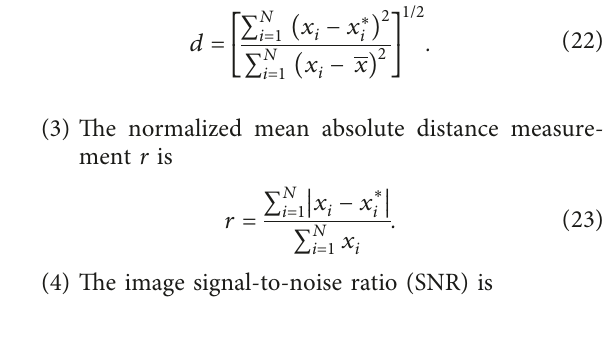
Figure 5: Three basic projection matrix calculation methods. (a) Projection matrix based on 0, 1. (b) Length-based projection matrix. (c) Area-based projection